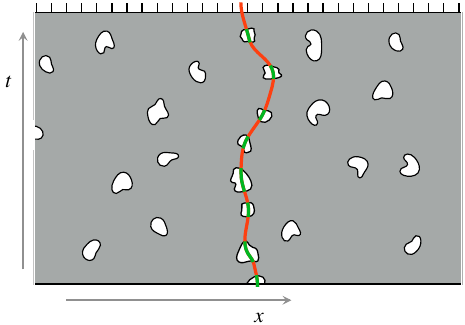
FIG. 6. Cartoon of the minimal cut in the entangling phase for S 0 (at L ¼ ∞ ). The small white domains are clusters of broken bonds: We only show those clusters that the minimal cut passes through. A minimal cut is shown traversing the spacetime patch. The red sections have nonzero cost per unit length, while the green regions have zero cost. In the entangling phase, the cost of the minimal cut scales like t (with subleading KPZ fluctuations), so S 0 ð t Þ ∼ t .